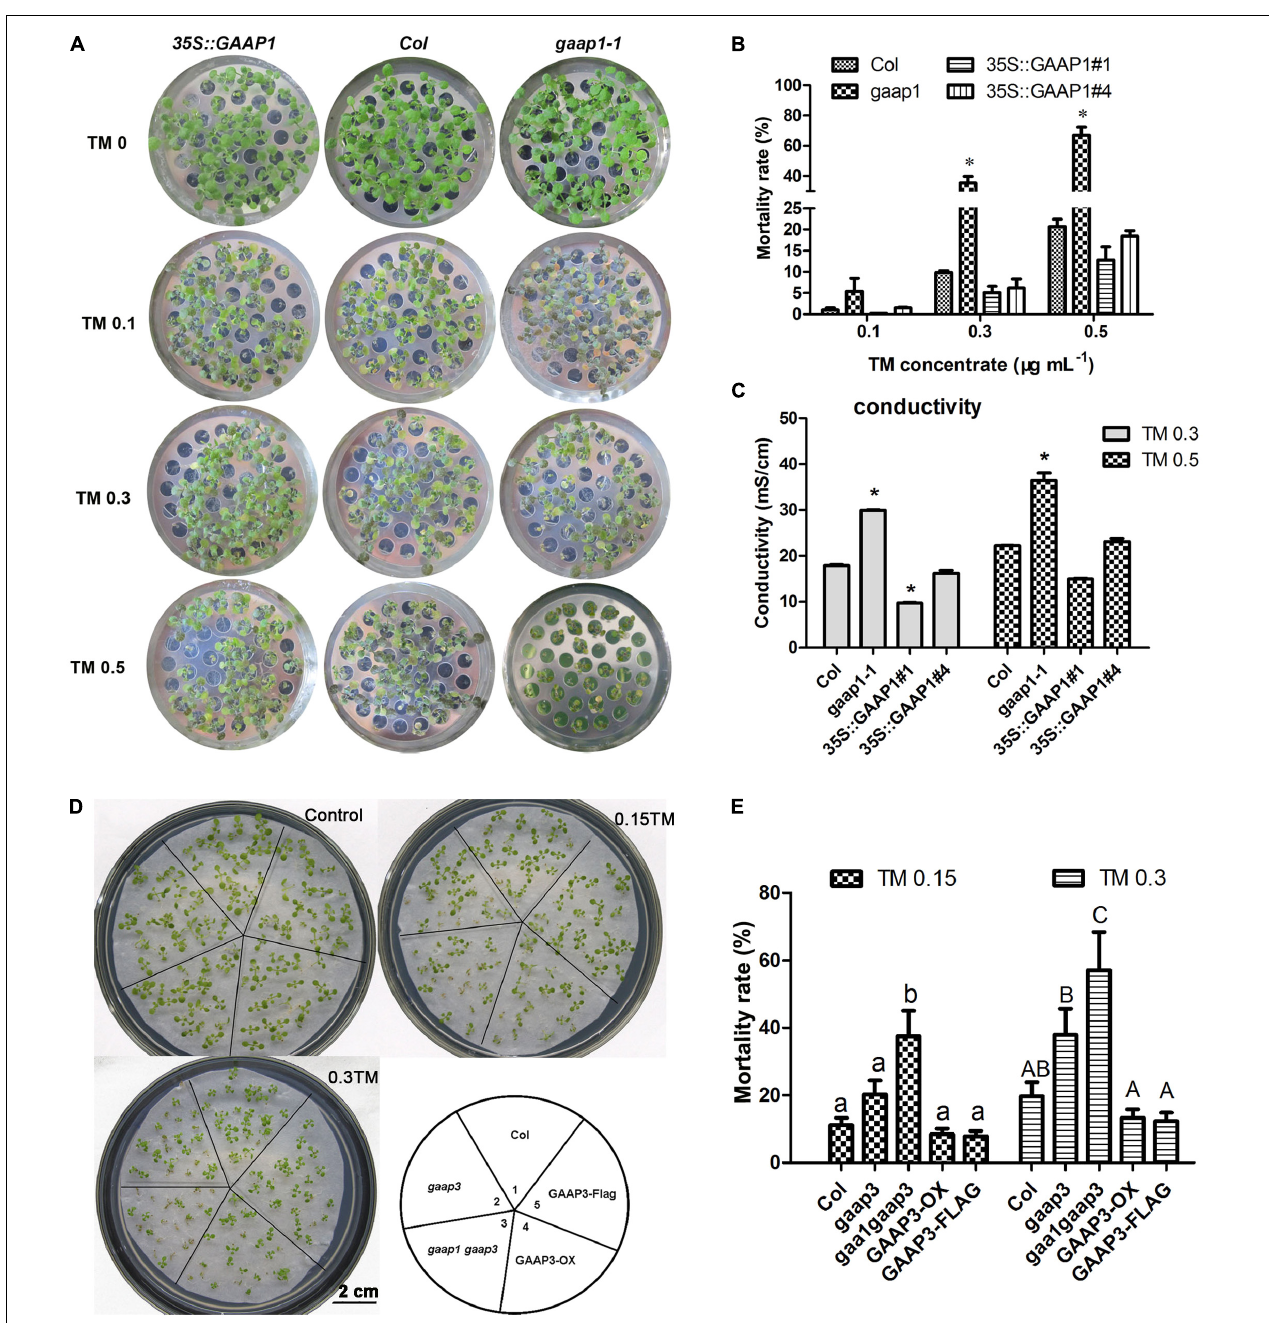
FIGURE 4 | Mutation of GAAP1 and/or GAAP3 enhanced plants sensitivity toward TM. (A–C) GAAP1 mutation-enhanced plant death induced by TM. (A) Growth of Col, 35S::GAAP1#1 seedlings on 1/2 MS medium for 5 days, and then moved on 1/2 MS medium supplied with different concentrations (0–0.50 µ g mL − 1 ) of TM for 1 week. (B) Mortality rate of GAAP1 -overexpressing transgenic plants, and Col and gaap1-1 treated with different concentrations of TM for 1 week. Error bars depict SE of six independent experiments. Error bars depict SD. Significant differences compared with Col plants at the same concentrations of TM, as indicated by asterisks ( ∗ p < 0.05, n > 80). (C) Damage of GAAP1-overexpressing transgenic plants, Col and gaap1-1 treated with 0.3 and 0.50 µ g mL − 1 TM for 1 week. Shoots were collected from the samples obtained from the different sets of seedlings performed for (B) and then subjected to ion leakage measurements. Data are expressed as mean ± SD . Significant differences compared with Col plants at the same concentrations of TM, as indicated by asterisks ( ∗ p < 0.05, n = 3). (D,E) GAAP3 single mutation or GAAP3 and GAAP1 double mutations reduced the resistance of plants to ER stress. Phenotypes (D) and mortality rates (E) of Col, gaap3, gaap1gaap3 , GAAP3 -OX, and GAAP3 -FLAG, which grew on 1/2 MS medium without or with 0.15 and 0.30 µ g mL − 1 TM for 10 days. Data are expressed as mean ± SE of five independent experiments. Different letters indicate significant differences between different plants with the same TM treatment subjected to χ 2